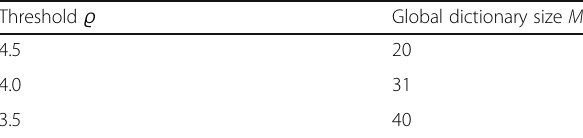
Table 2 Global dictionary size in function of threshold ϱ Threshold